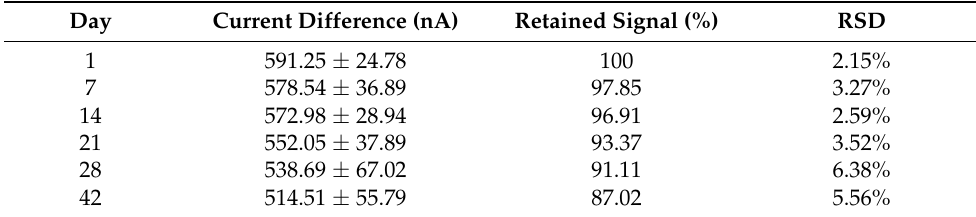
Table 1. The long-term stability of biosensor in 300 µ M NH 4+ solution at pH 7.5 ( n = 3).